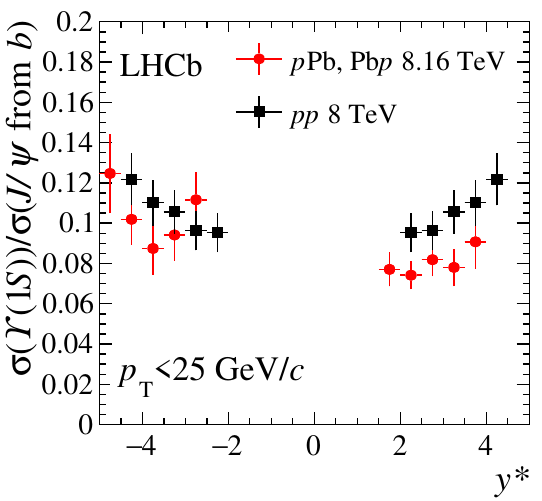
Figure 11 . Double ratios for (left) (cid:7) (2 S ) and (right) (cid:7) (3 S ). The bands correspond to the theo- retical prediction for the comovers model as reported in the text.